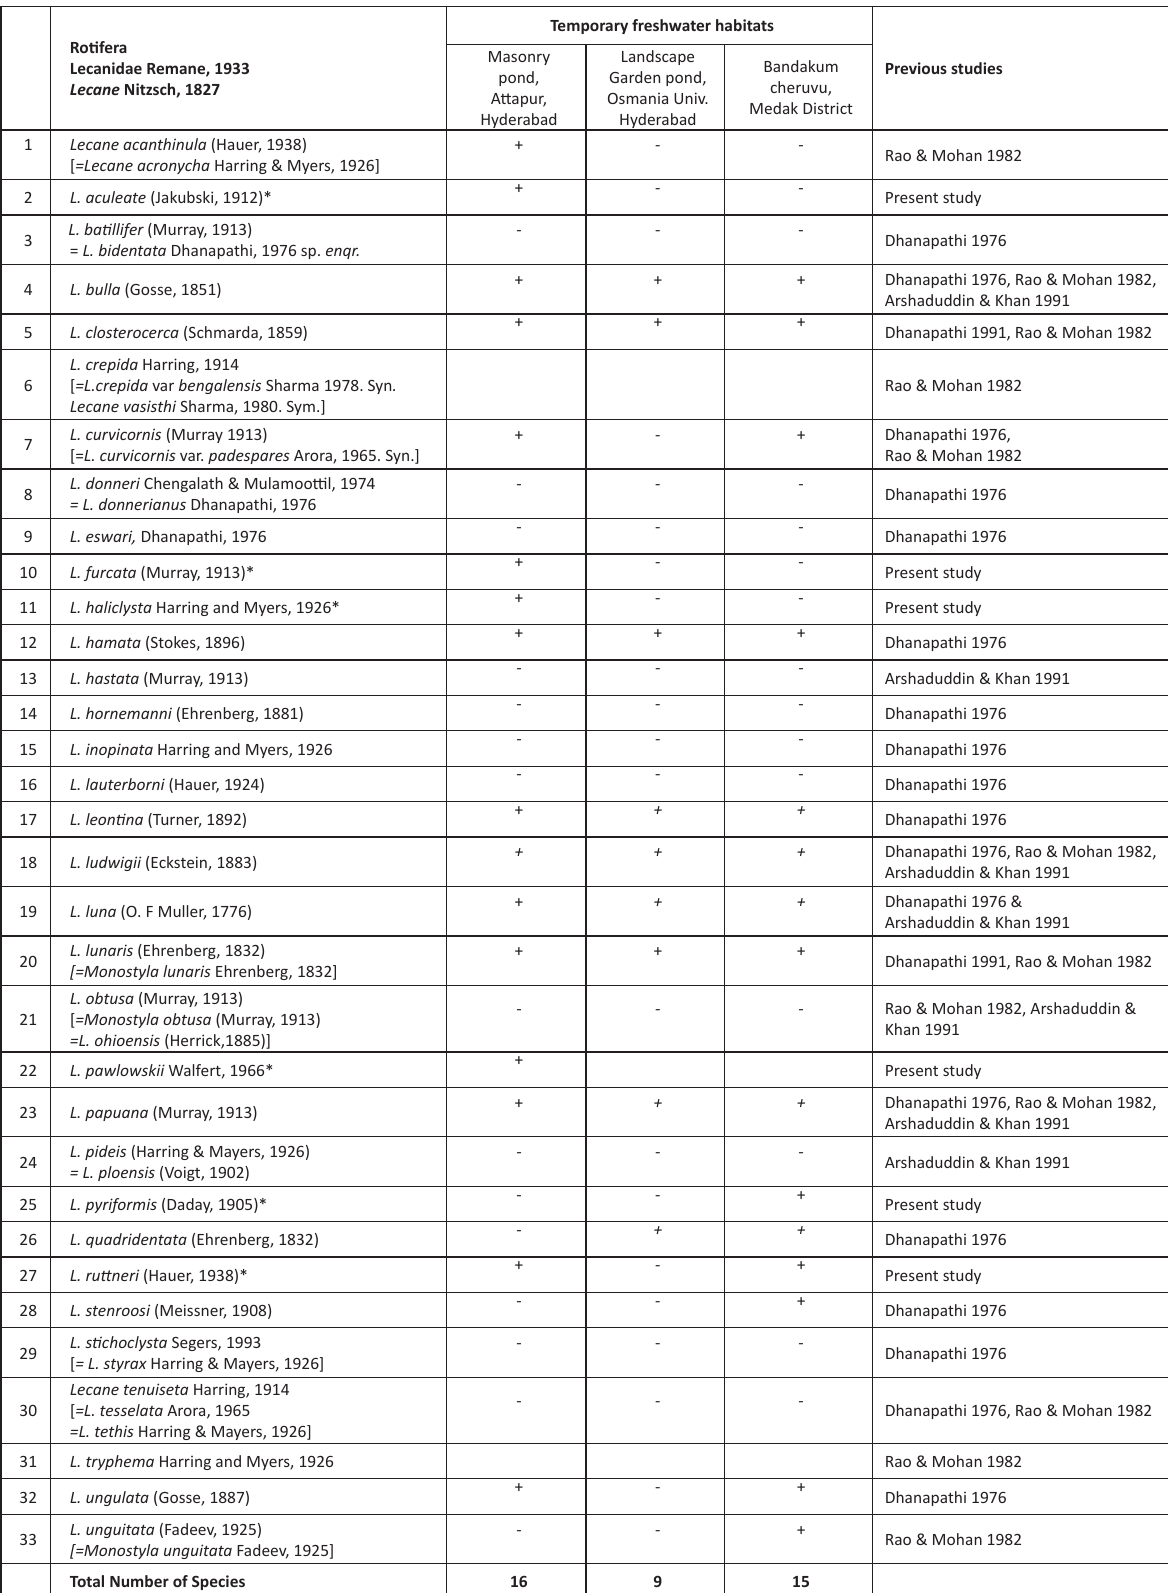
Table. 1 List of Lecane species reported from Hyderabad, Andhra Pradesh, India. (dhanapathi 1976 onwards). Asterisk (*) as superscripts against the taxon name indicates first geographic records, while + (plus) sign indicates occurrence and – (Minus) as nonoccurrence. Rotifera Lecanidae Remane,